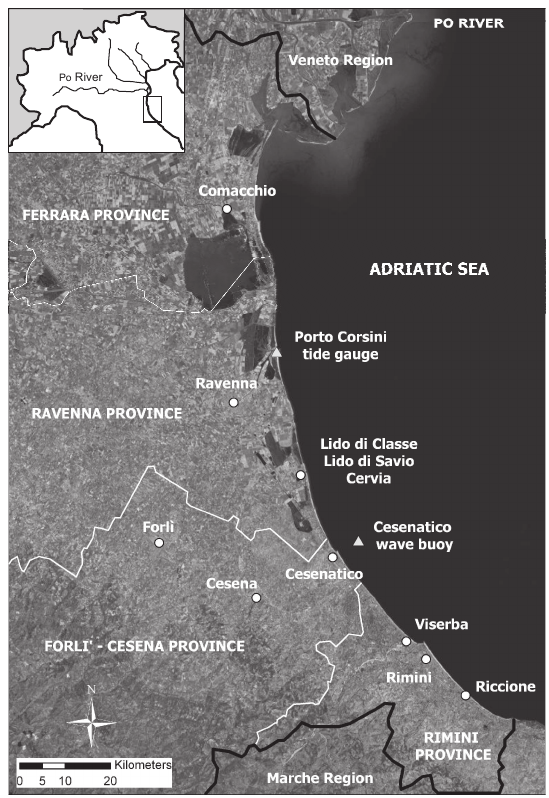
Figure 1. The Emilia-Romagna coastal area, northern Italy: loca- tion of places addressed in the text, as well as main cities and coastal